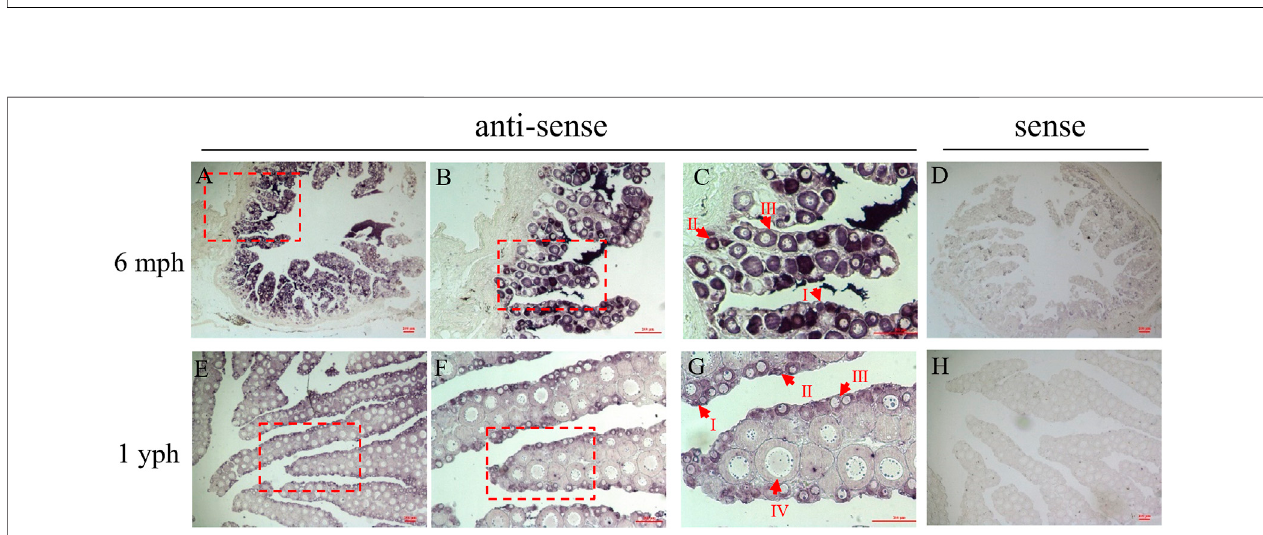
FIGURE 3 | Relative expression of pitp β _w in different tissues from female (A) and different developmental stages of the ovary (B) . Expression levels with different letters indicate a signi fi cant difference ( p < 0.05).